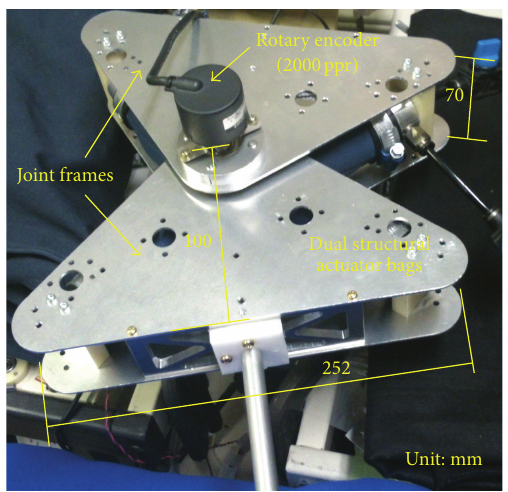
Figure 7: Prototype joint with the actuators.